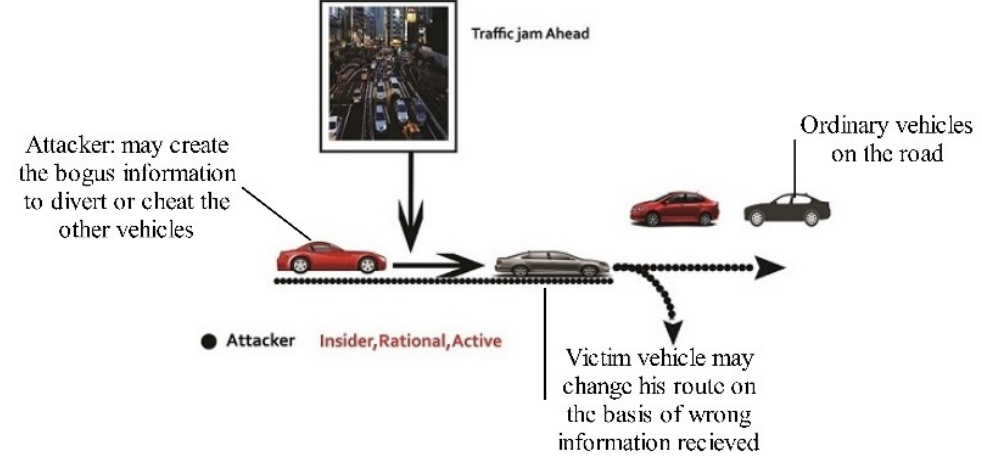
Figure 14. Jamming attack in SDN-based VANETs.